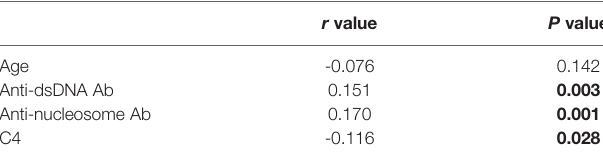
TABLE 2 | Correlations of O.D. values for anti-DFS70 antibodies with clinical